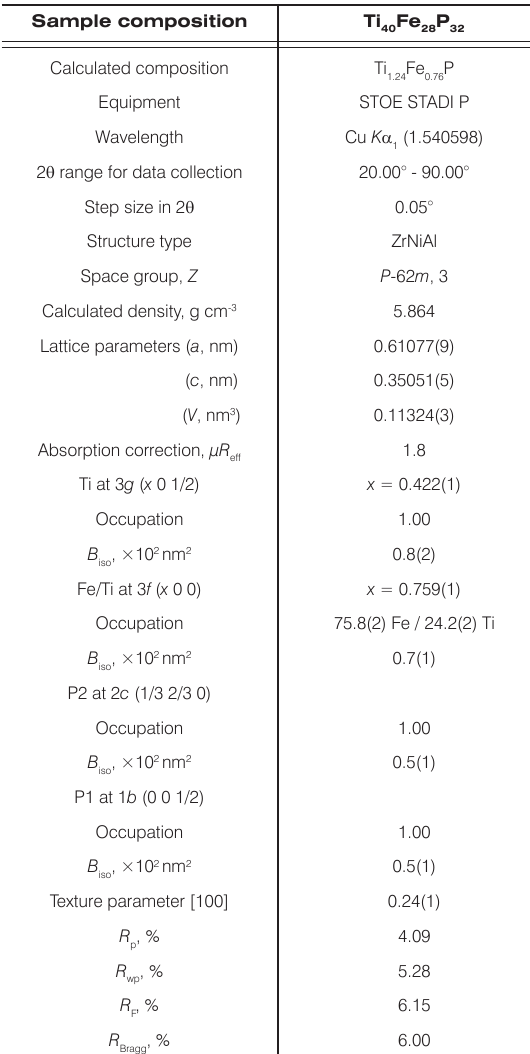
Table 6. Results of structure refinements for the Ti